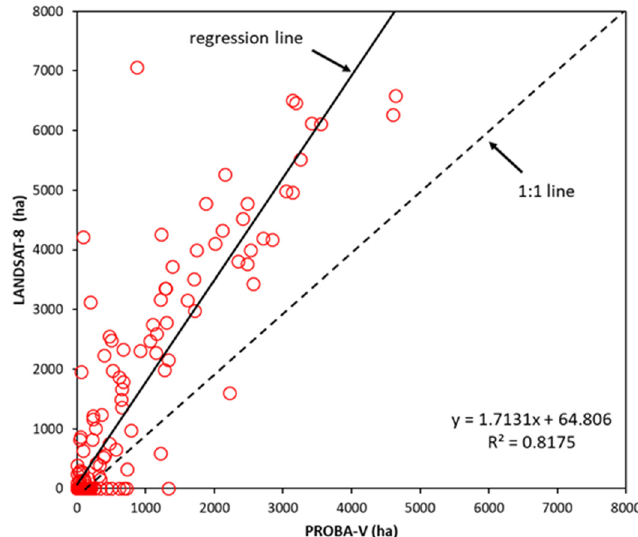
Figure 15. Relation between annual croplands estimated by Landsat-8 OLI and corresponding estimation by PROBA-V 100 m in the 288 sampling units. Continuous line refers to the linear regression line. Dashed line refers to the 1:1 line.